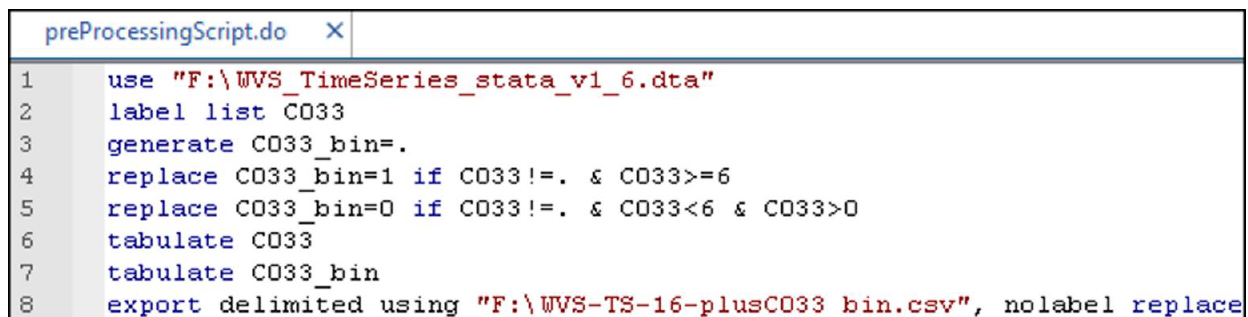
Figure 1 — preProcessingScript.do Figure 1—preProcessingScript.do (https://drive.google.com/u/0/uc?id=1sQNtMANw M3DzP5CAl2u3Io-xD6f5_4xW&export=download, accessed on 1 June 2022).